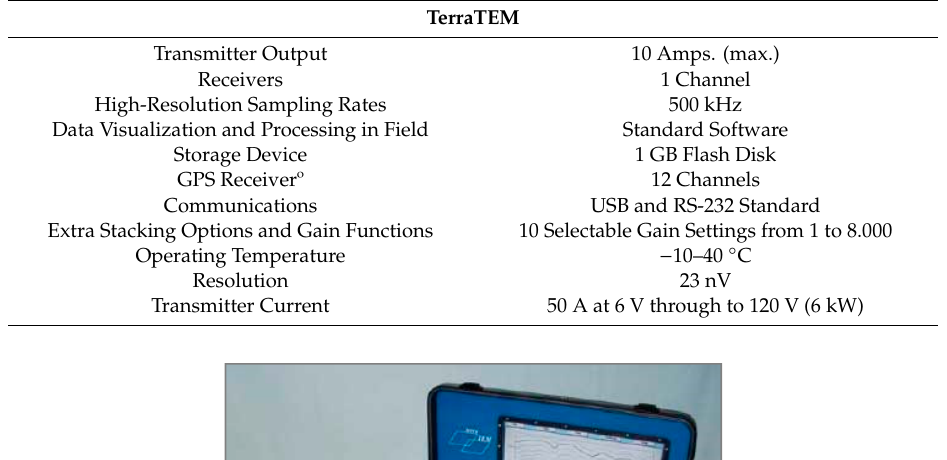
Table A1. Specifications of TerraTEM device.